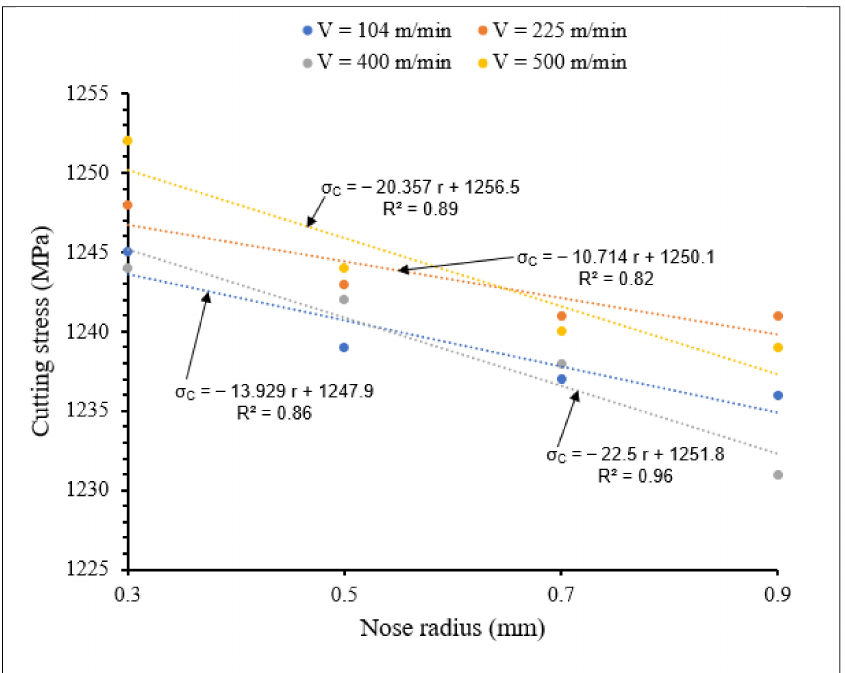
Figure 18. Variation of cutting stress with small tool nose radius for different cutting speeds at f = 0.1 mm/rev, γ = 5 ◦ .